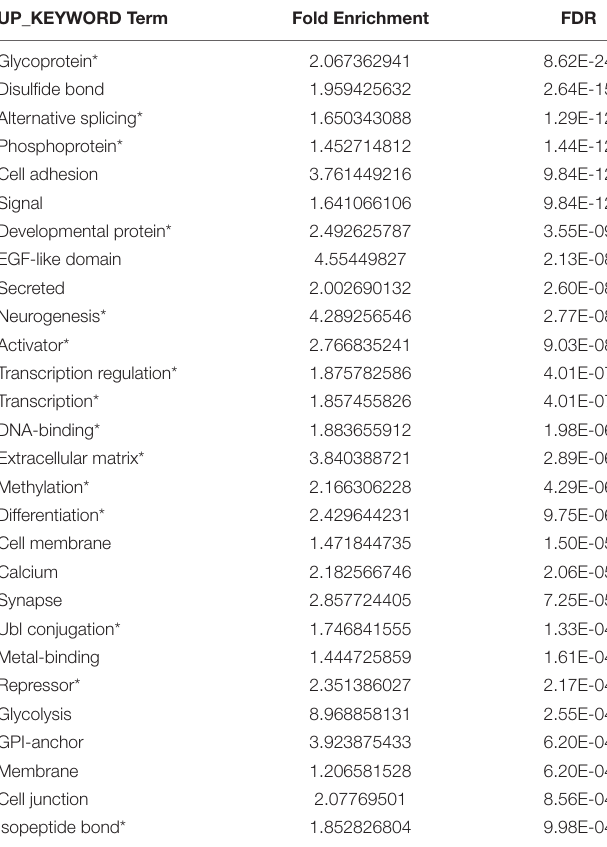
TABLE 1 | Results of DAVID analysis of DEGs in E13.5 Dio3 − / − brain. TABLE 2 | Results of DAVID analysis of DEGs in E18.5 Dio3 − / − brain.